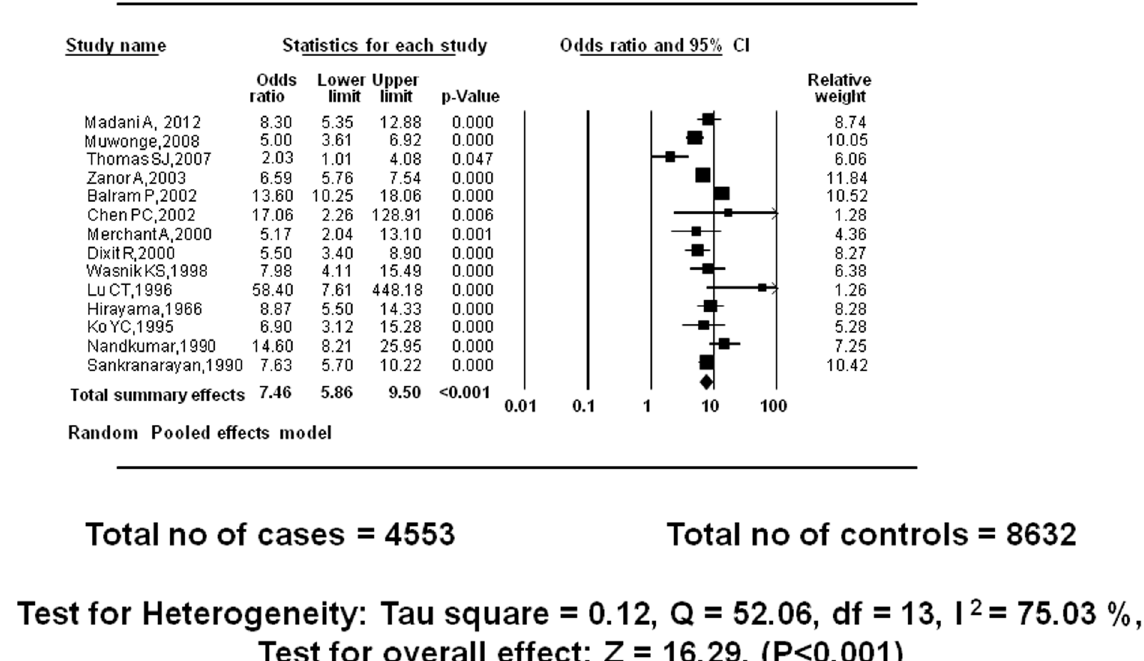
Figure 2. Meta-analysis of case-control studies: ST NOS use and incidence of oral cancer.